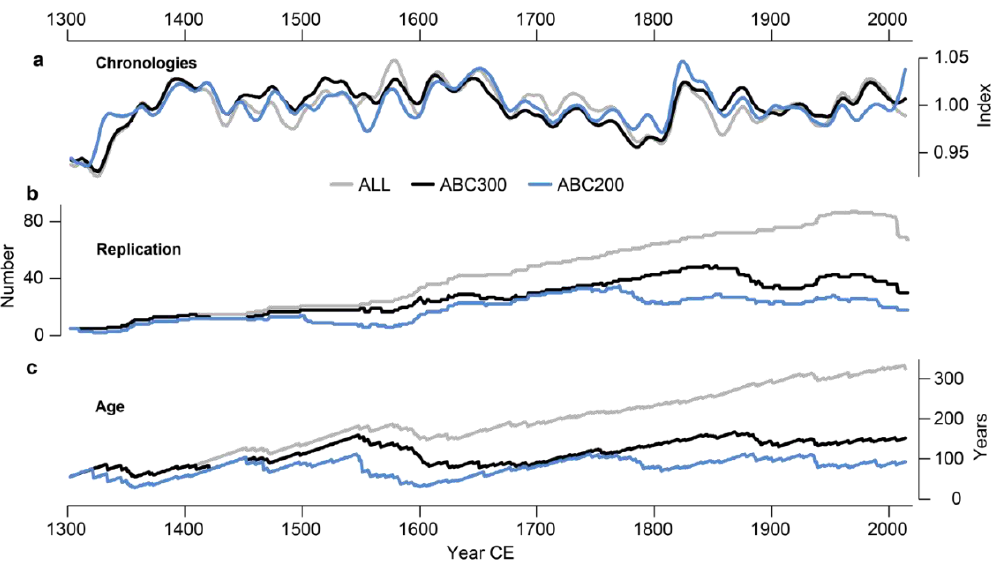
Figure 4. Cazorla MXD chronologies and characteristics. ( a ) Thirty-year smoothed Regional Curve Standardization (RCS) chronologies of the full MXD data (gray), the 1–300 age band data (black), and the 1–200 age band data (blue), shown together with their replication ( b ) and mean age curves ( c ). See Supplementary Figure S4 for the original (non-smoothed) chronologies and mean segment length curves.